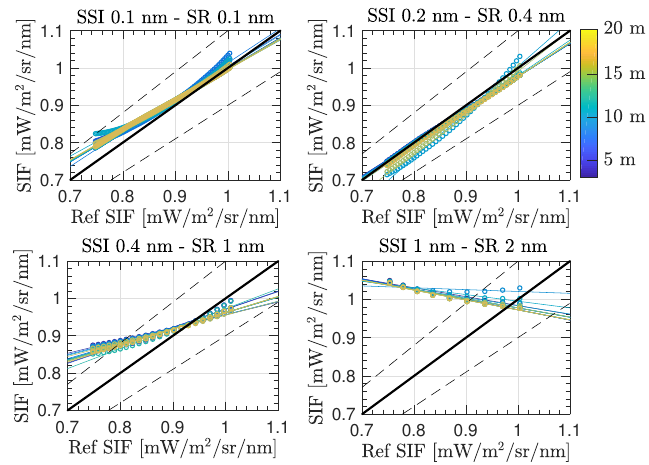
Figure 12. Scatter plots showing reference SIF versus estimated SIF in the interval between 759.0–767.5 nm, using the proposed SFM retrieval approach to compensate for oxygen effects while also accounting for the instrument spectral convolution effects, for different instrument spectral resolutions and sensor heights above TOC between 3 m to 20 m (colour scale). Coloured solid lines are regression lines for the range of sensor heights evaluated while actual estimations are marked as circles. The black solid lines represent the 1:1 line and dashed lines define the areas with a SIF relative error lower than 10%.